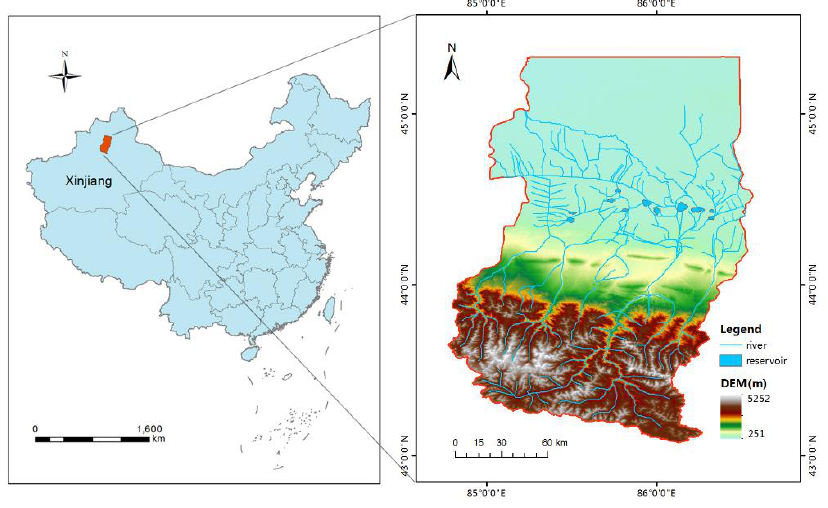
Figure 1. Location and scope of the study area.